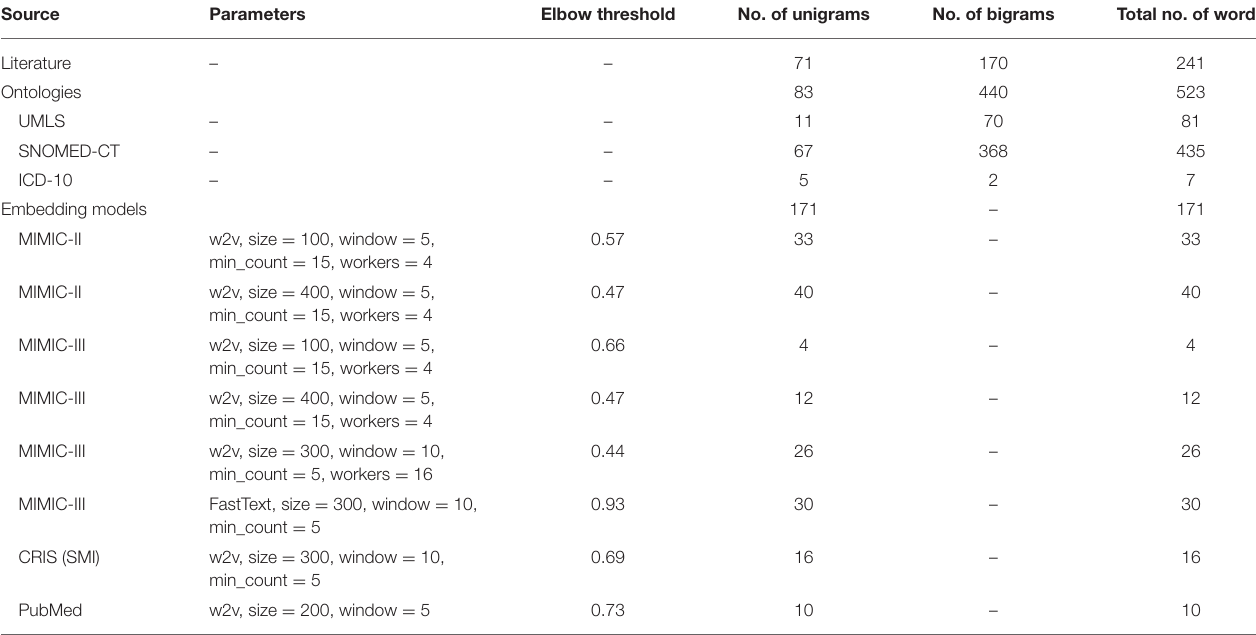
TABLE 6 | Number of words obtained from the different sources, and parameters/elbow threshold for the embedding models.